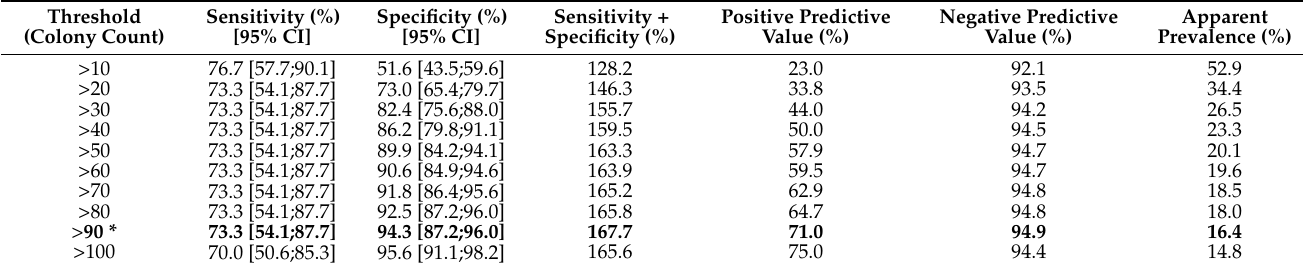
Table 2. Diagnostic performance of the Tri-plate on-farm culture system based on different colony count thresholds in comparison with the reference laboratory ( n = 189).